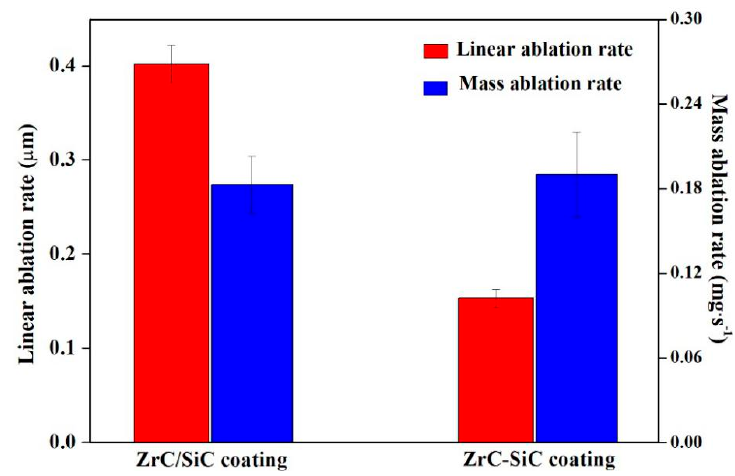
Figure 4. The results of ablation tests.